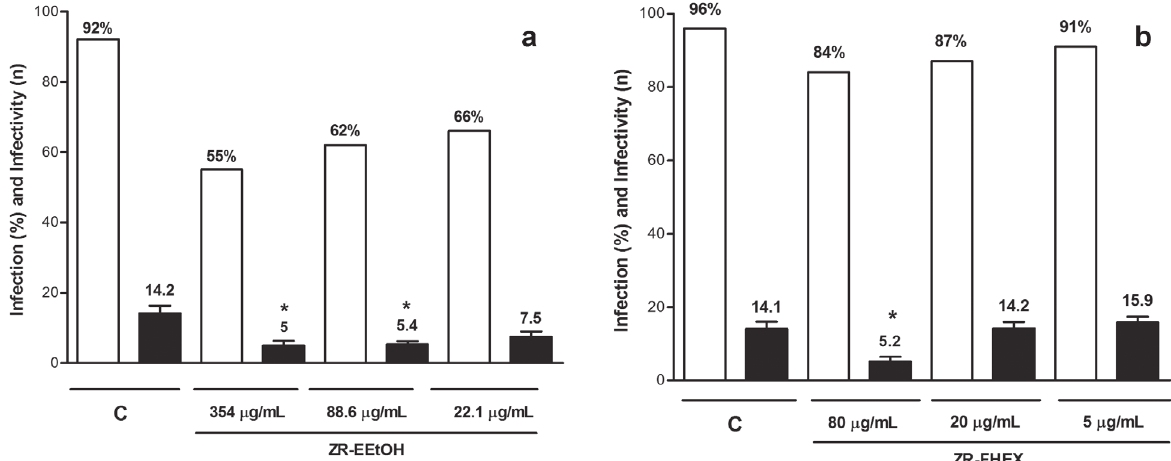
Figure 1 - Effect of pretreatment of macrophages with ZR-EEtOH or ZR-FHEX, expressed by percentage of macrophages infection ( £ ) and average number of amastigotes per infected macrophage ( ¢ ). Values are expressed as mean  s.e.m. One-way ANOVA followed by Bonferroni’s post-test; * p <0.05 compared with control.